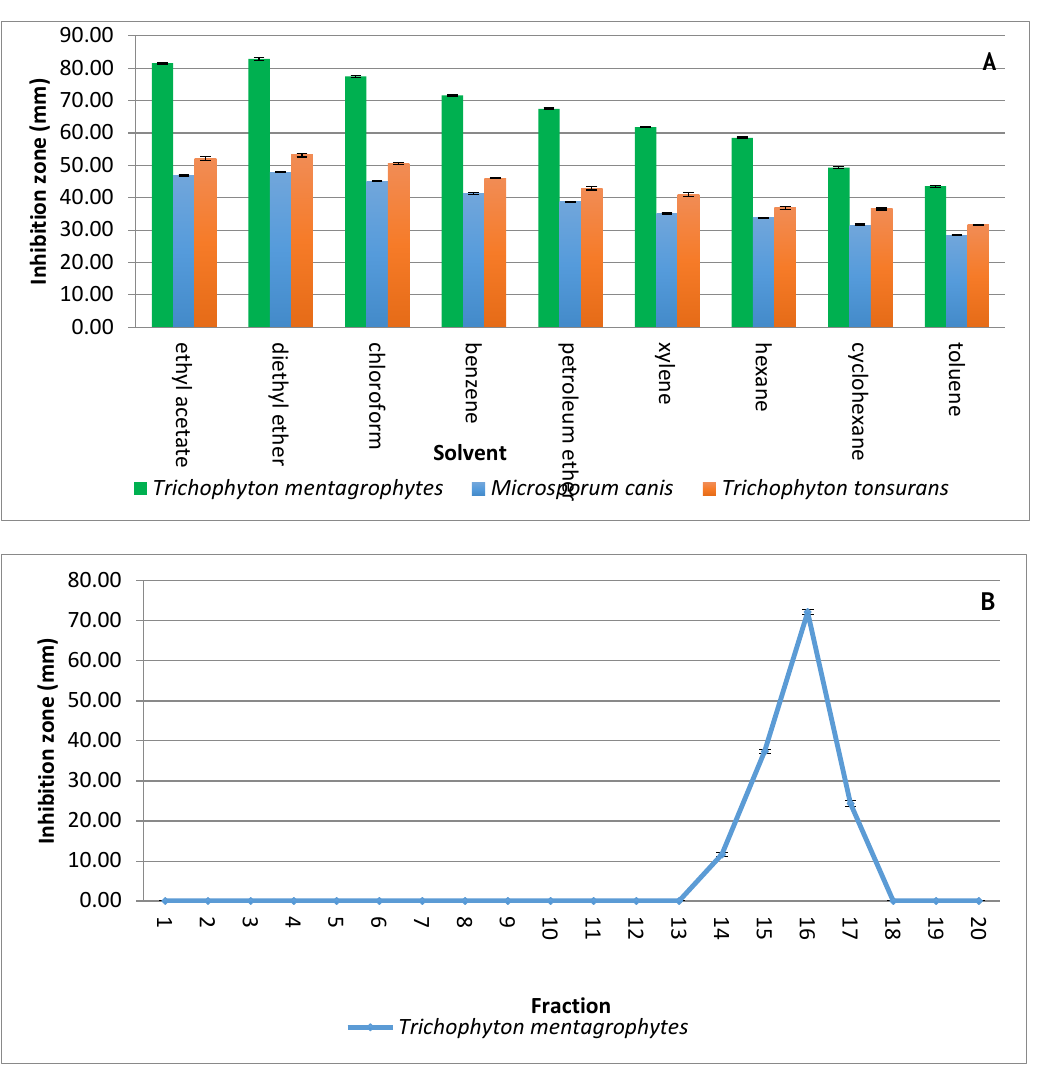
Figure 3. Extraction and purification of the antidermatophytic substance(s) produced by S. atrovirens ( A ); Antidermatophytic activity as showed by inhibition zone diameter of different solvent extracts of S. atrovirens ; fractions eluted using column chromatography respectively ( B ). Results are the average of three replicates ± SE.